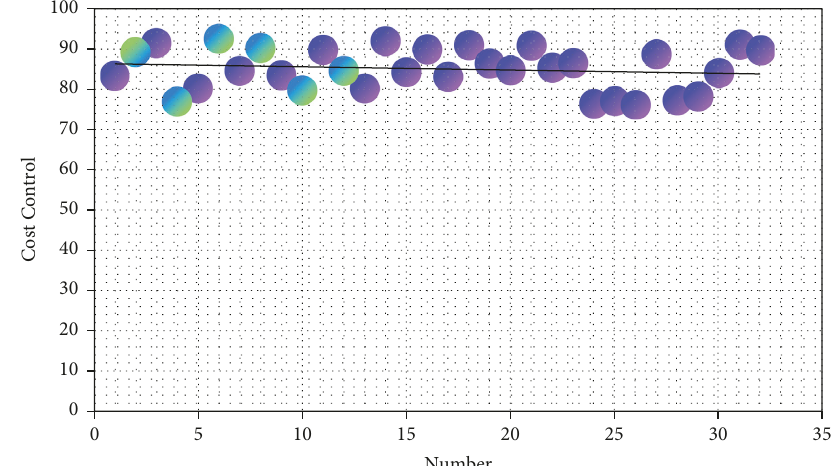
Figure 12: Statistical diagram of cost control